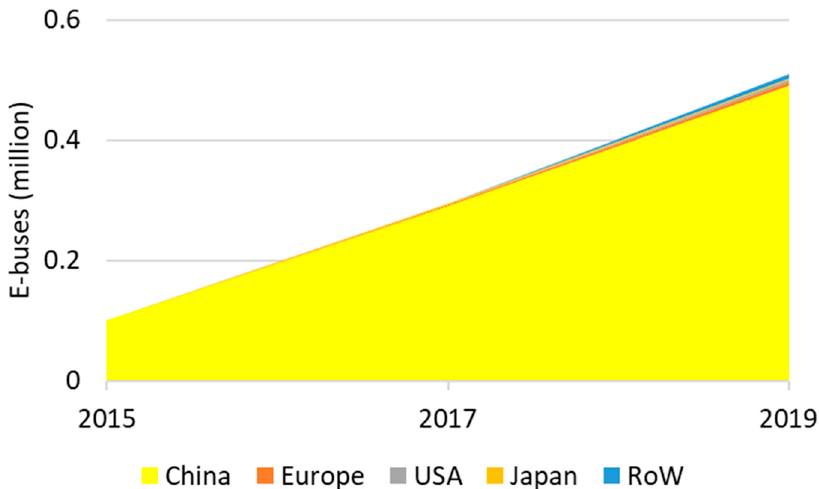
Figure 10. Development of the global stock of E-buses (Data source: [56]).